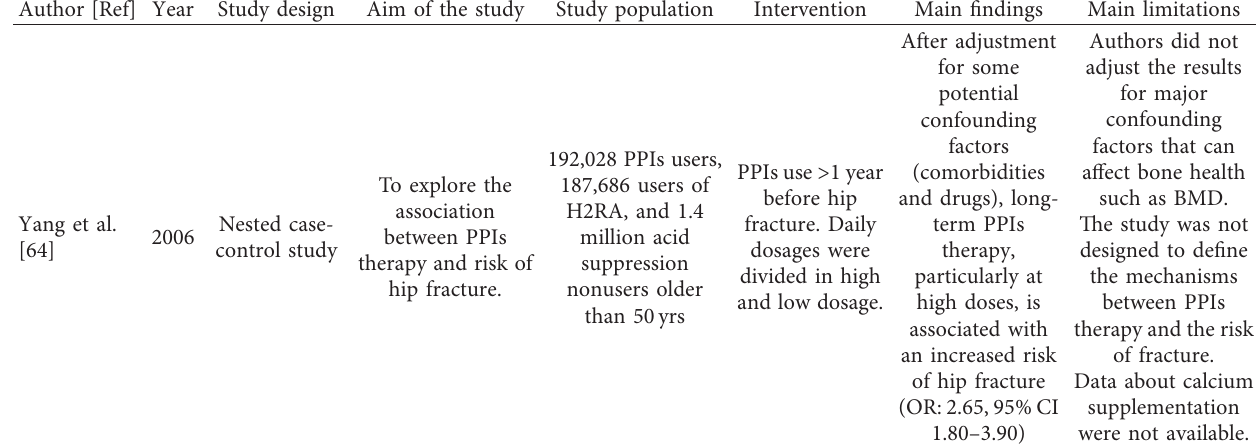
Table 1: Main characteristics of studies regarding PPIs and risk of